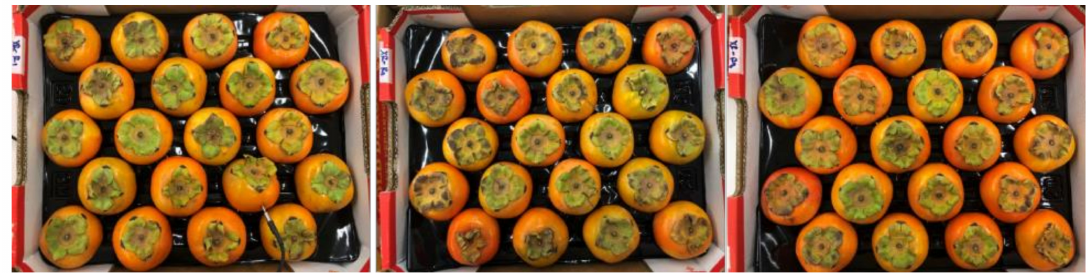
Figure 2. Untreated control (UTC) ( top ) and treated ( lower ) ‘Jiro’ persimmon fruit three days after treatment.